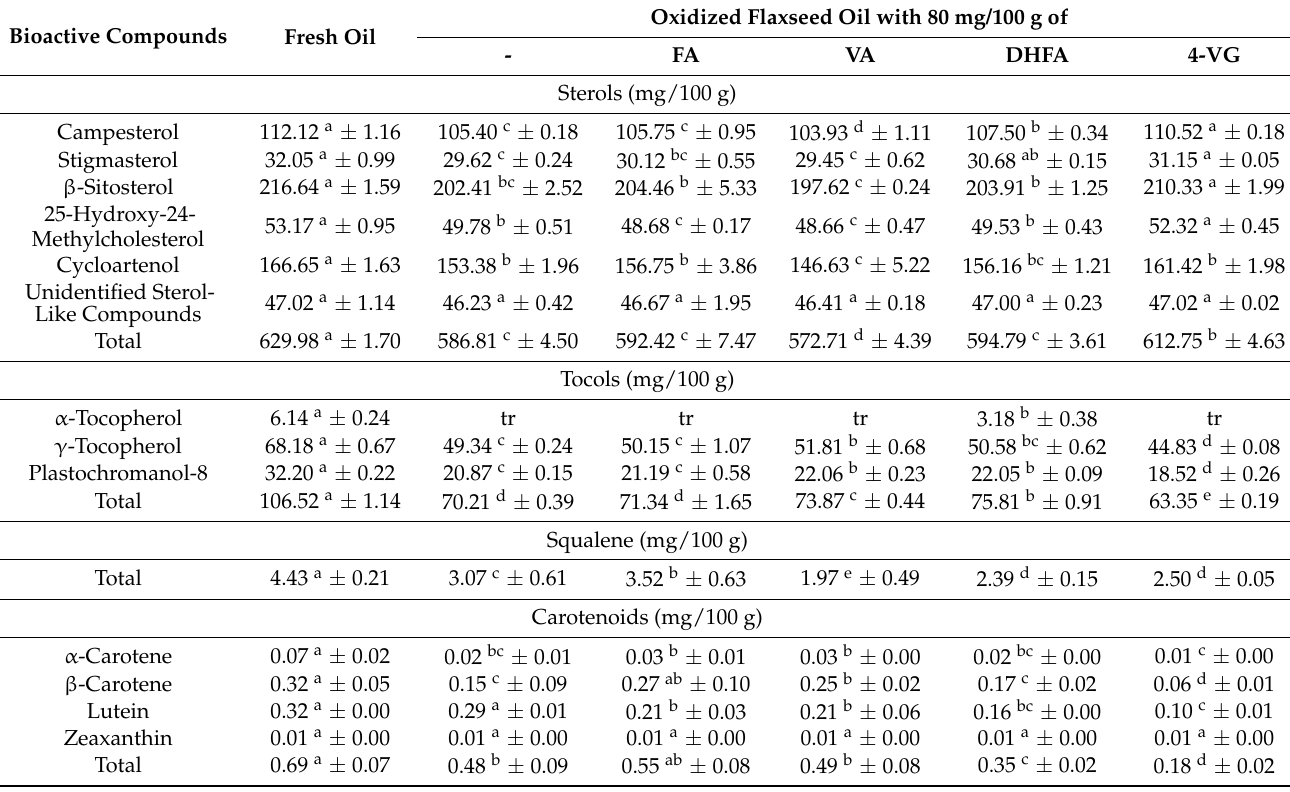
Table 4. Content of lipophilic bioactive compounds ( ± SD) in fresh cold-pressed flaxseed oil and oxidized at 60 ◦ C without and with phenolic